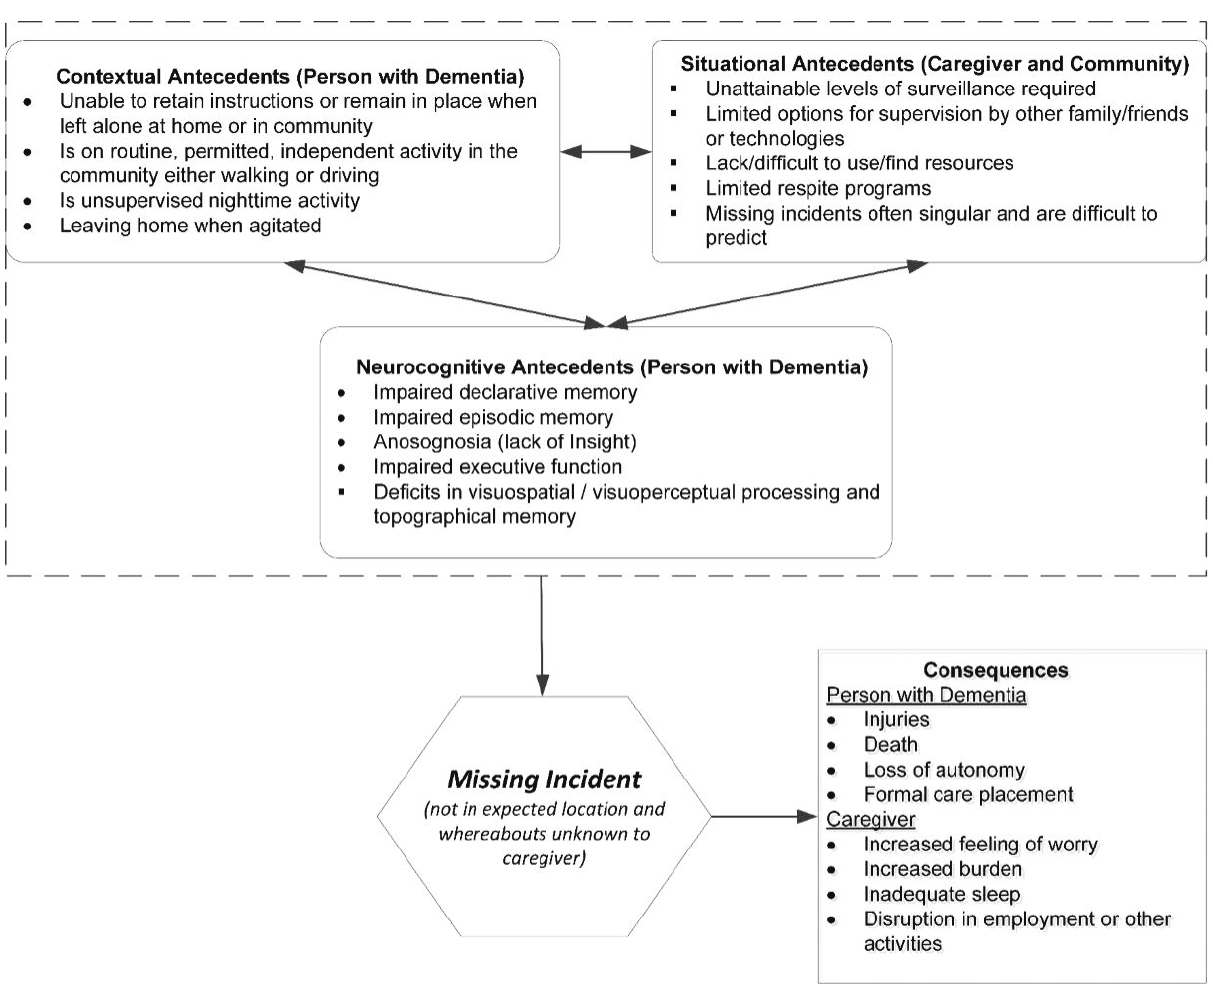
Figure 1. Missing Incident Conceptual